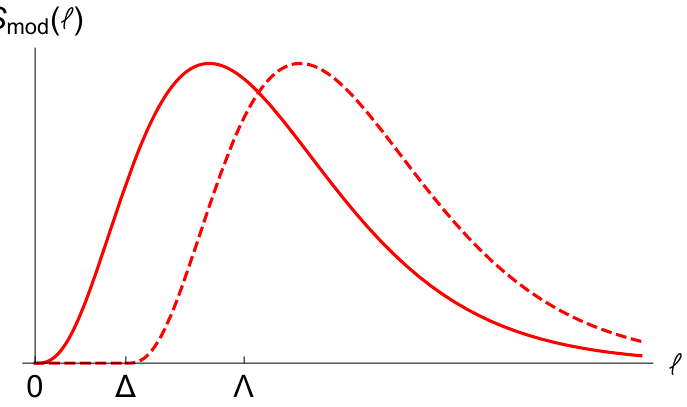
Figure 3. Generic form of the soft model shape function S mod ( ‘ ) in arbitray units for illustration. The original soft model shape function S mod ( ‘ ) is represented by the solid red line and the soft model shape function with a gap shift, S mod ( ‘ (cid:1)) for the case 0 < (cid:1) < (cid:3), by the dashed red line. (cid:0)